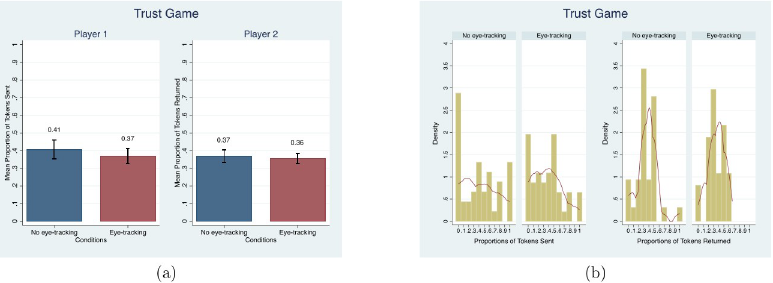
Fig 3. Mean and distribution comparisons in the proportions of tokens sent and returned. Note. For reciprocity, those who received 0 tokens as Player 2 were treated as missing values [78]. The x-axis in the histogram represents the proportion of tokens the players received. Red lines in (b) present the univariate kernel density estimation.